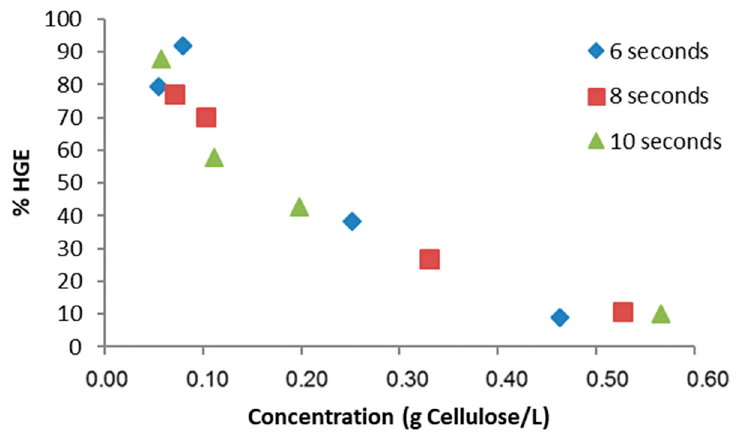
Figure 6. E ff ect of cellulose initial concentration in SCWG processes at 250 bar, 535 ◦ C, and with n = Figure 6. Effect of cellulose initial concentration in SCWG processes at 250 bar, 535 °C, and with n = 0.4.